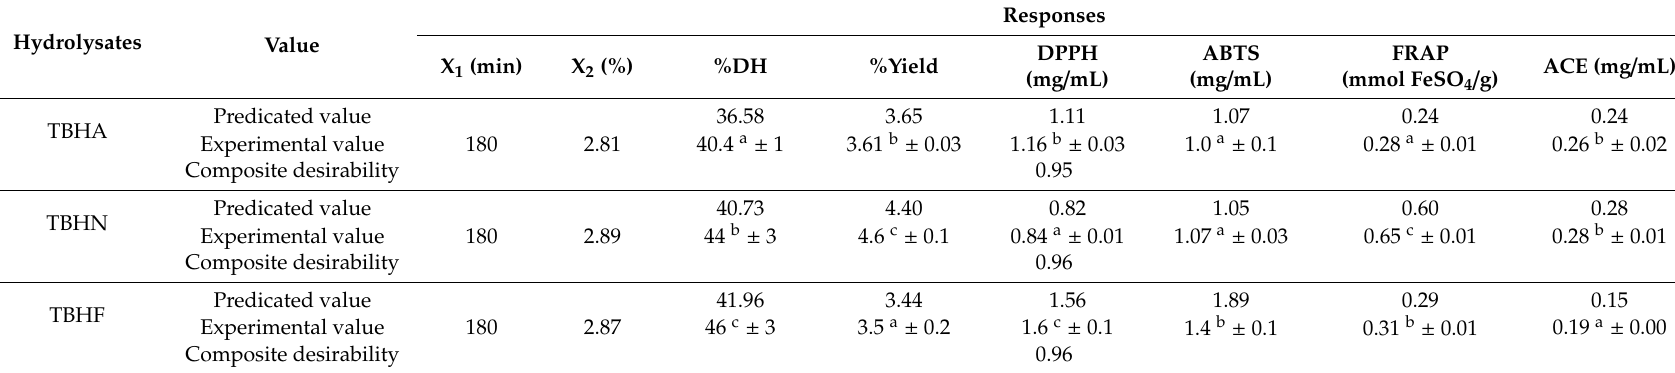
Table 3. Optimum condition with predicated values and experimental values from the verification of optimum models for all responses of TBH using Alcalase (TBHA), Neutrase (TBHN) and Flavourzyme (TBHF) hydrolysis.